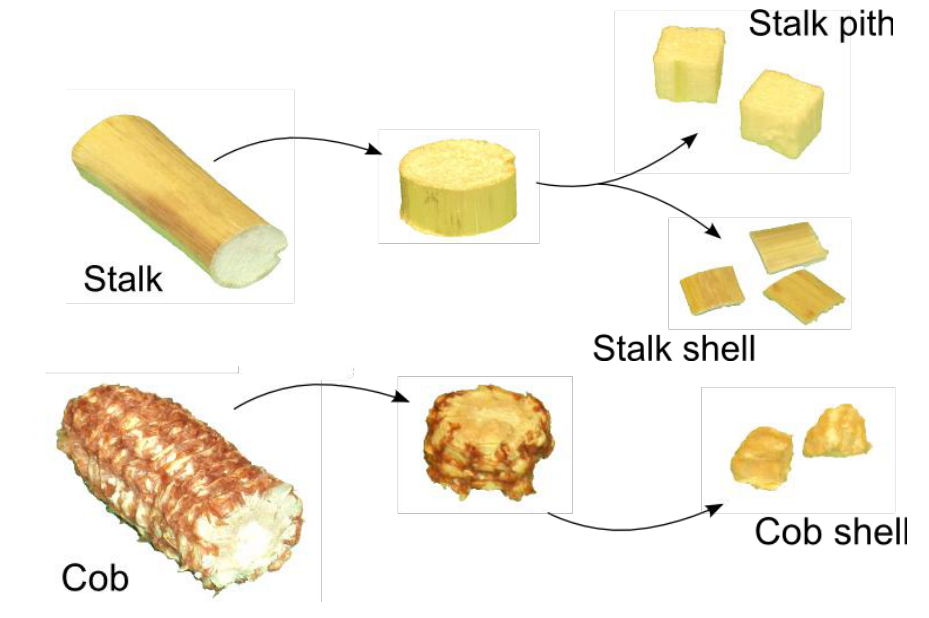
Figure 1. Different corn stover components.